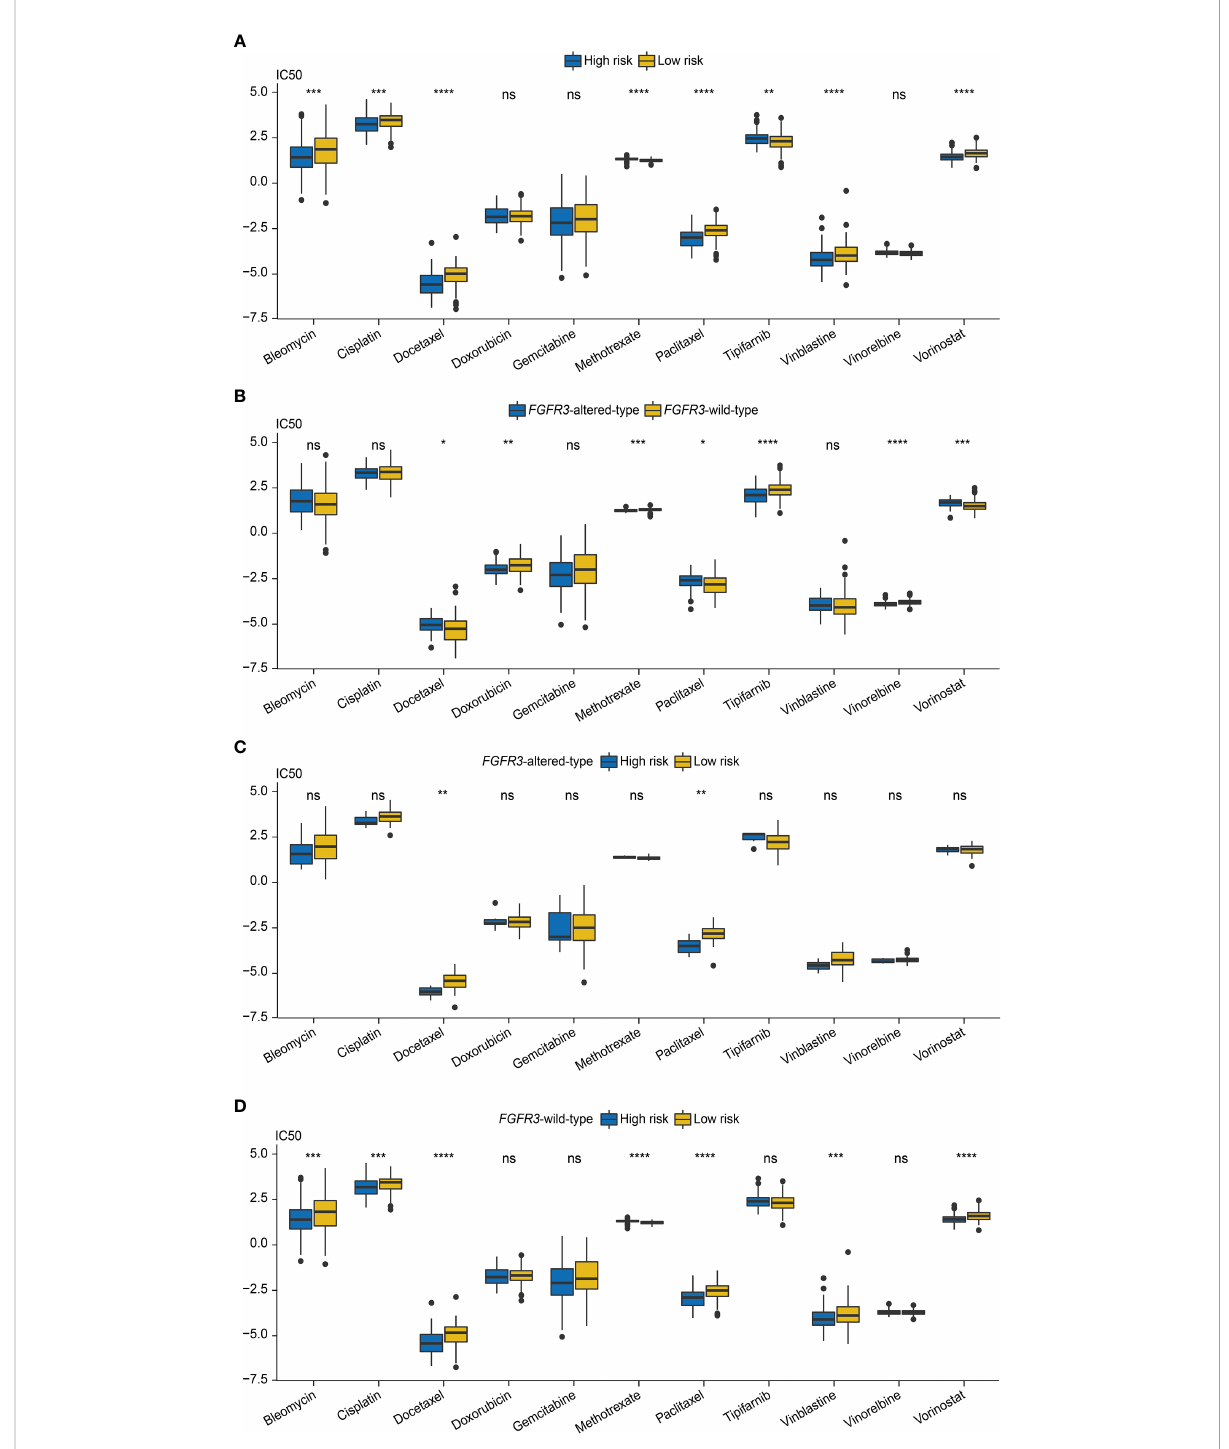
FIGURE 11 The evaluation of chemotherapy response based on the analysis of Genomics of Drug Sensitivity in Cancer (GDSC). (A) The comparison of IC 50 values between high- and low-risk groups. (B) The comparison of IC 50 values between patients with FGFR3 alterations or with wild-type FGFR3 . (C) The comparison of IC 50 values between high- and low-risk groups of patients with FGFR3 alterations. (D) The comparison of IC 50 values between high- and low-risk groups of patients with wild-type FGFR3 . * indicated p < 0.05, ** indicated p < 0.01, *** indicated p < 0.001, **** indicated p < 0.0001, ns indicated no statistically signi fi cant